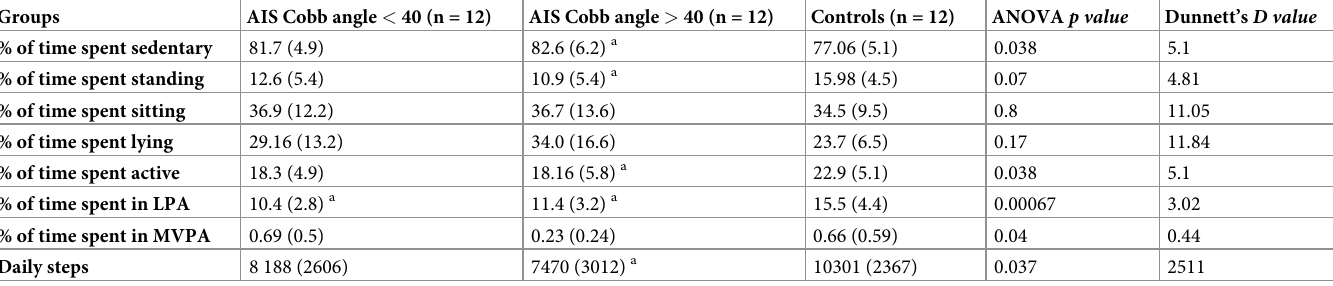
Table 3. Activity and sedentary behavior during weekdays. Mean (SD).